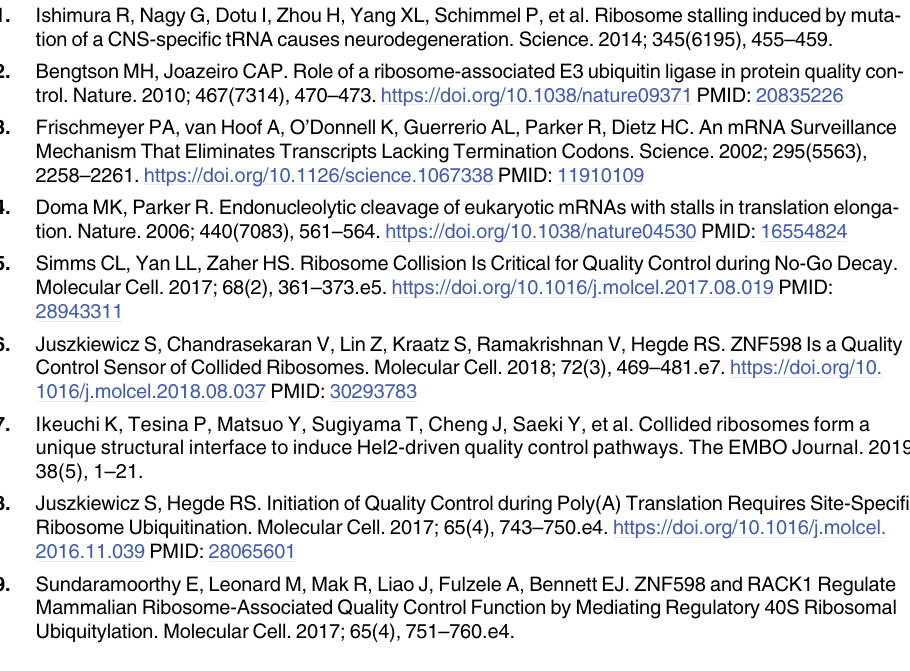
S6 Fig. HBS-1 and PELO-1 exhibit similar phenotypes during NGD in C . elegans . Mean RFUs (relative fluorescence units) of indicated strains (n � 15 animals/strain) in the unc-54 (rareArg) background. One standard deviation shown as error bars. p values from Welch’s t- test, with asterisks indicating p < 0.01 for all comparisons with wild type.